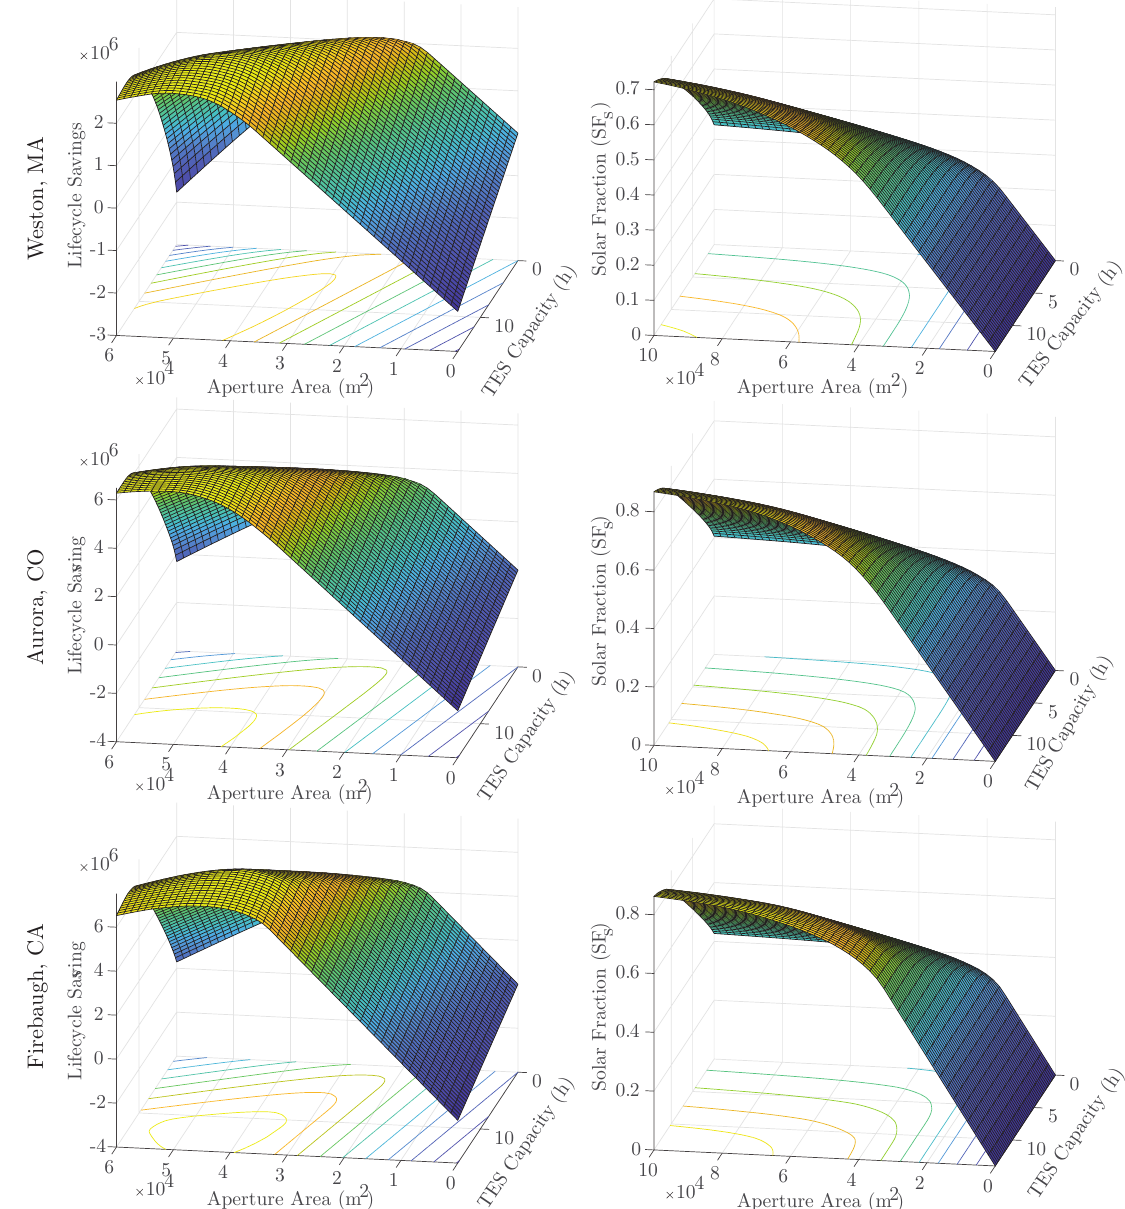
Figure 4. The objective function surfaces f fix ( left column ) and the solar fraction surfaces SF s ( right LCS column ) for constant IPH demand for commercial fuel rate show similar qualitative trends between each region